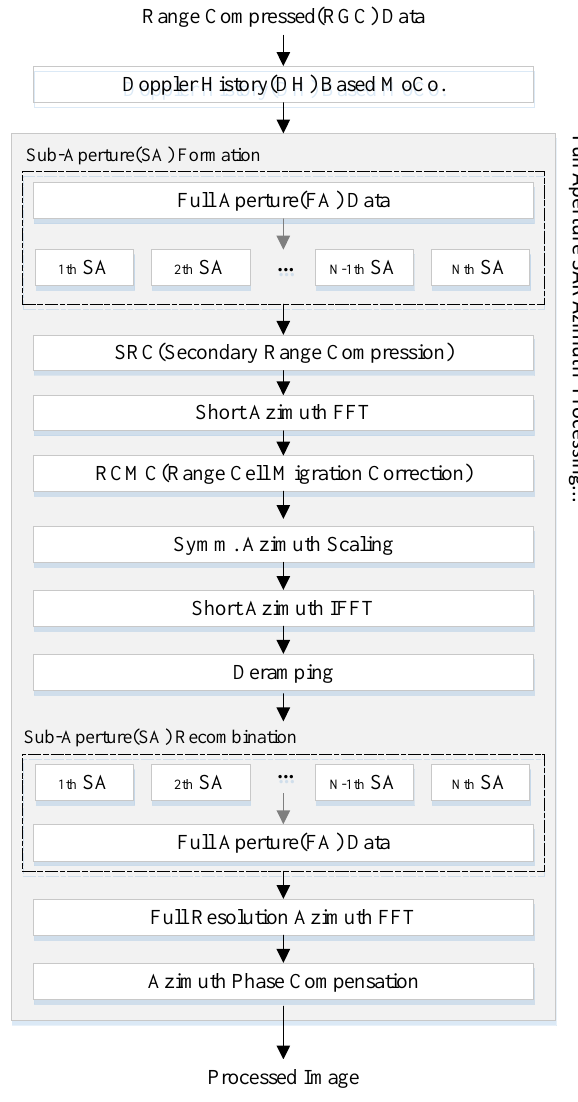
Figure 4. Block diagram of the proposed ISAR full aperture processor with motion compensation.